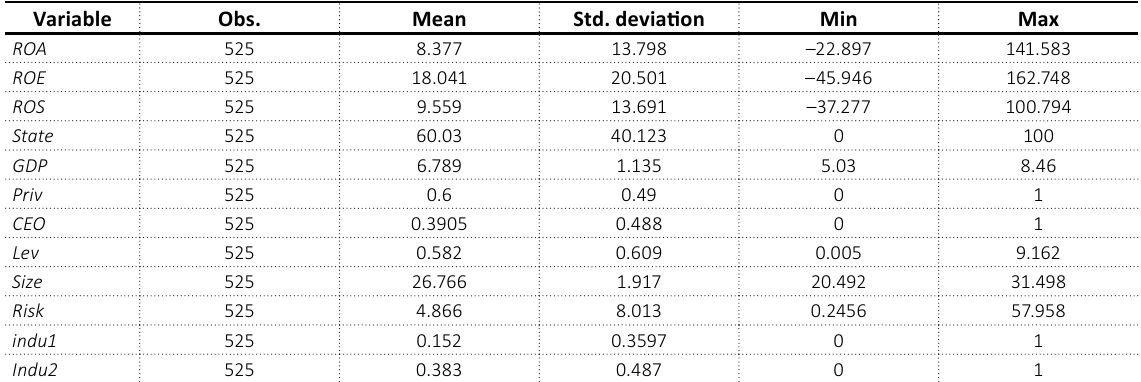
Table 4. Summary of variables of the model